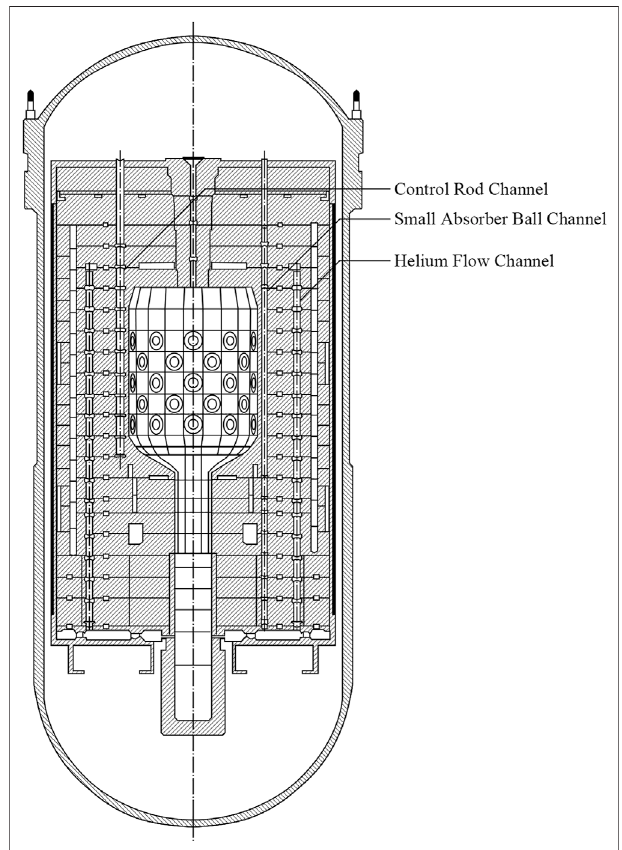
FIGURE 1 | HTR-10 reactor vertical cross-section (IAEA,